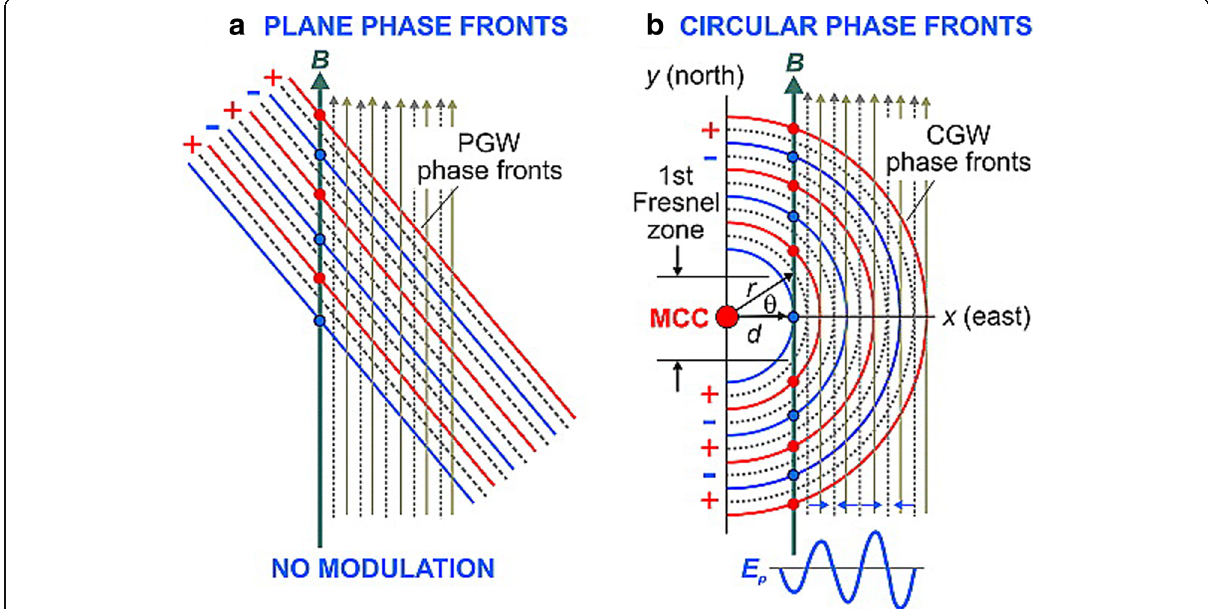
Fig. 9 Diagram showing the polarization response to the presence of gravity waves with a planar and b circular phase fronts (after Tsunoda 2010a,